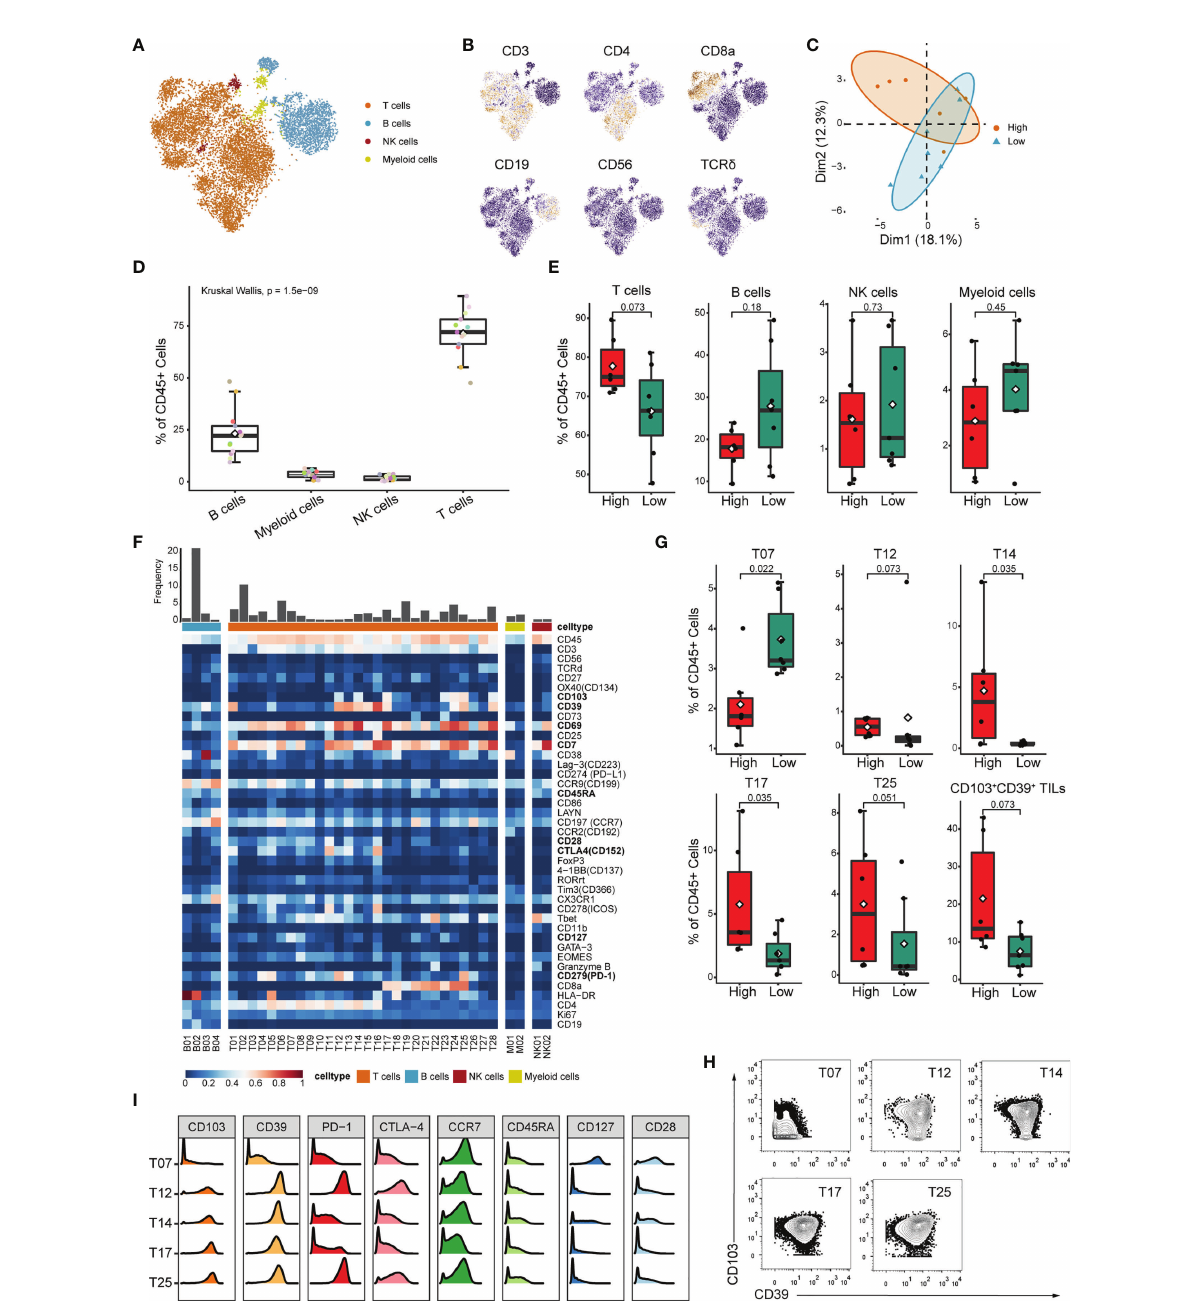
FIGURE 4 Identi fi cation of detailed immune pro fi les of CRC TILs by mass-cytometry. (A) tSNE plot displaying T cells, B cells, NK cells and myeloid cells based on manual annotation. (B) tSNE plots of normalized expression of markers used to annotate main immune clusters. (C) PCA analysis of cluster frequencies in the two IRScore groups. Each dot represented one patient. (D) Boxplot showing the frequency of B cell, myeloid cell, NK cell and T cell for each sample. (E) Comparison of frequencies of T cell, B cell, NK cell and myeloid cell between high and low IRScore groups. (F) Heatmap of normalized marker expression for 36 immune clusters. (G) Boxplots showing signi fi cant differences of frequency in T07, T12, T14, T17, T25 and total CD103 + CD39 + TILs (T12+T14+T17+T24+T25) between high and low IRScore groups. (H) Contour plots showing expression of CD103 and CD39 in T07, T12, T14, T17 and T25. (I) Histograms showing expression of indicated markers in T07, T12, T14, T17 and